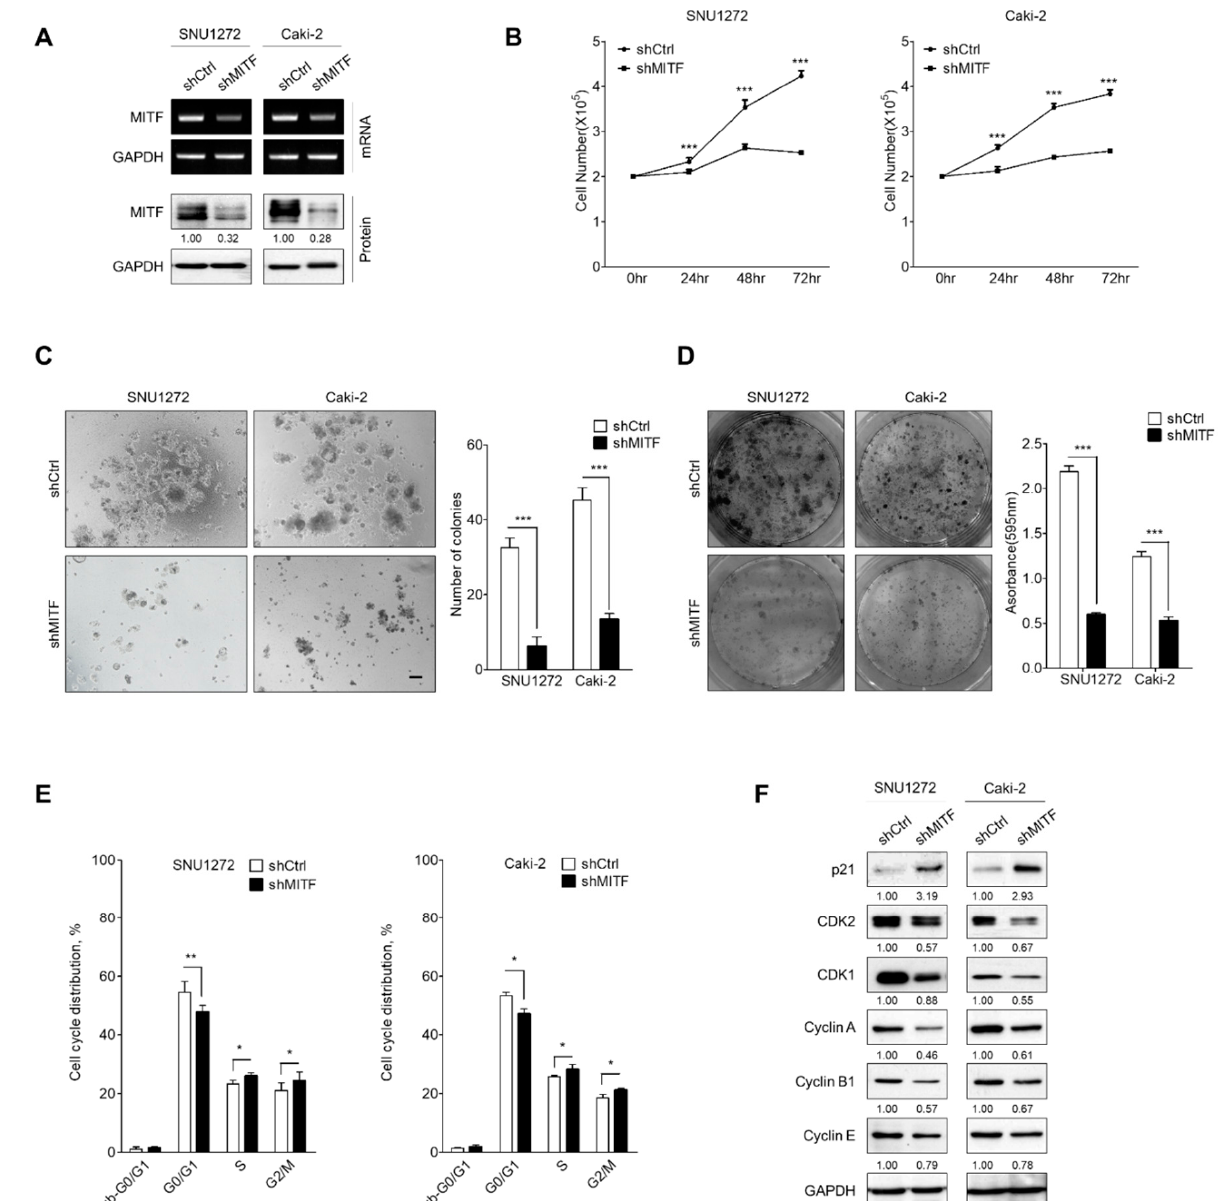
Figure 1. MITF knockdown suppresses cell proliferation and cell cycle progression. ( A ) Western blot analysis and RT-PCR of MITF in MITF-knockdown and shCtrl cells. Whole areas were measured using Image J software ( n = 3). Uncropped blots are shown in Figure S7. ( B ) Cell proliferation rates by cell counting assay in MITF-knockdown and shCtrl cells. Data are presented as the means ± standard deviation and were evaluated using Student’s t -test ( n = 3). ( C ) The anoikis assay was performed on an ultra-low attachment cell-culture plate. Single-cell suspensions grew into large spheroids. Data are presented as the means ± standard deviation and were evaluated using Student’s t -test ( n = 5). Scale bar, 100 µm. ( D ) The clonogenic assay was performed on a 6-well culture plate. Crystal violet-stained cells were dissolved in 70% alcohol, and absorbance at 595 nm was measured using a spectrophotometer. The data are presented as the mean ± standard deviation and were evaluated using Student’s t -test ( n = 3). ( E ) Cell cycle analysis by flow cytometry and the percentage of cells in sub-G0/G1, G0/G1, S and G2/M phases are annotated in each column. Data are presented as the means ± standard deviation and were evaluated using Student’s t -test ( n = 4). ( F ) Western blot analysis showing expression of cell cycle-related proteins. Whole areas were measured using Image J software ( n = 3). Uncropped blots are shown in Figure S7. *, p < 0.05; **, p < 0.01; ***, p < 0.001.